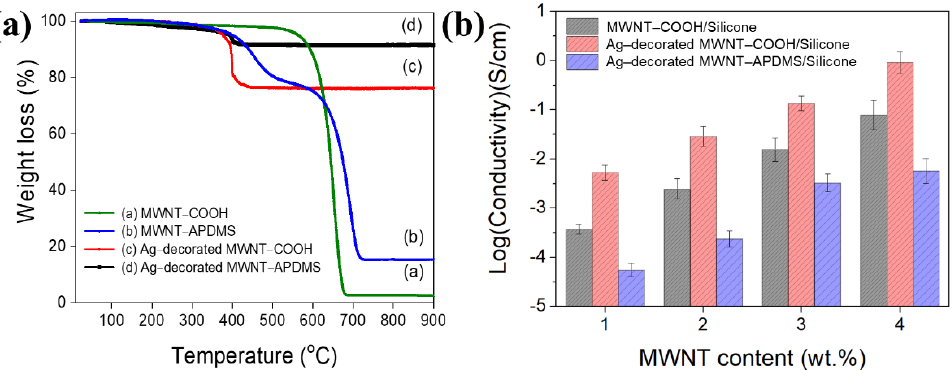
Figure 5. ( a ) TGA analysis curves of the samples and ( b ) The surface conductivity of silicone composite films depending on MWNT content.